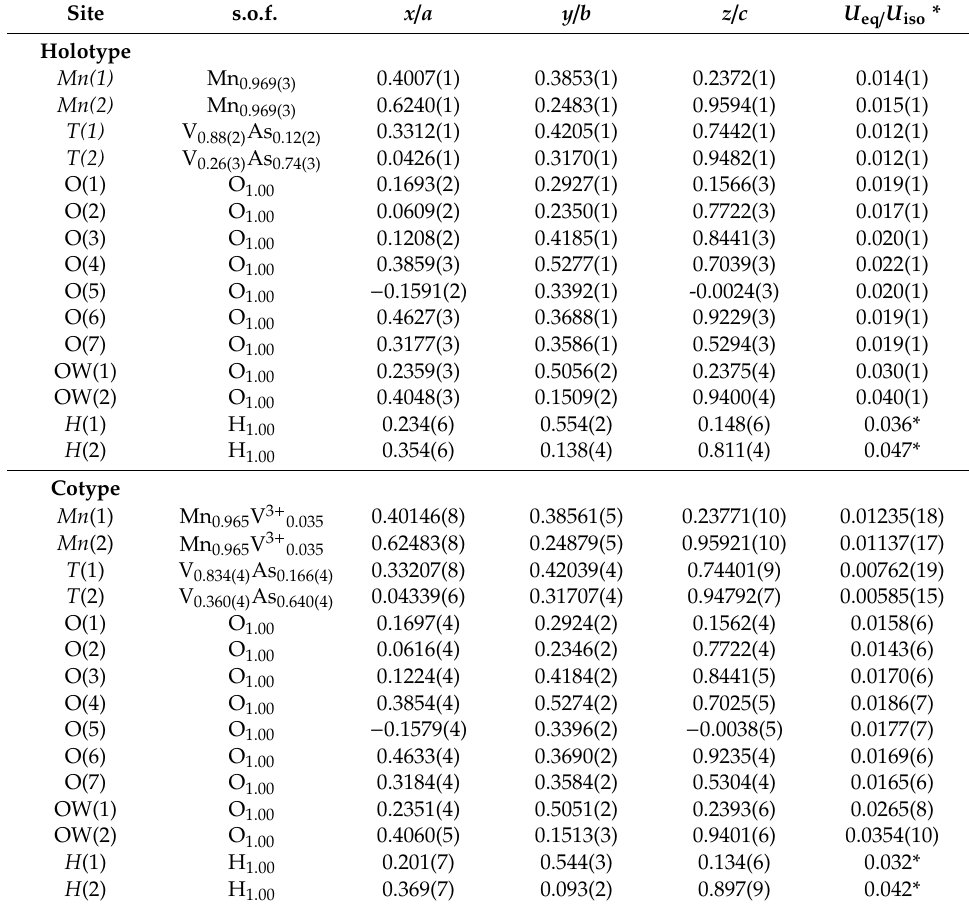
Table 4. Site Occupancy Factor (s.o.f.), Atom Coordinates and Equivalent and Isotropic Displacement Parameters (Å 2 ) for Rüdlingerite Holotype from the Fianel Mine and Cotype from the Valletta